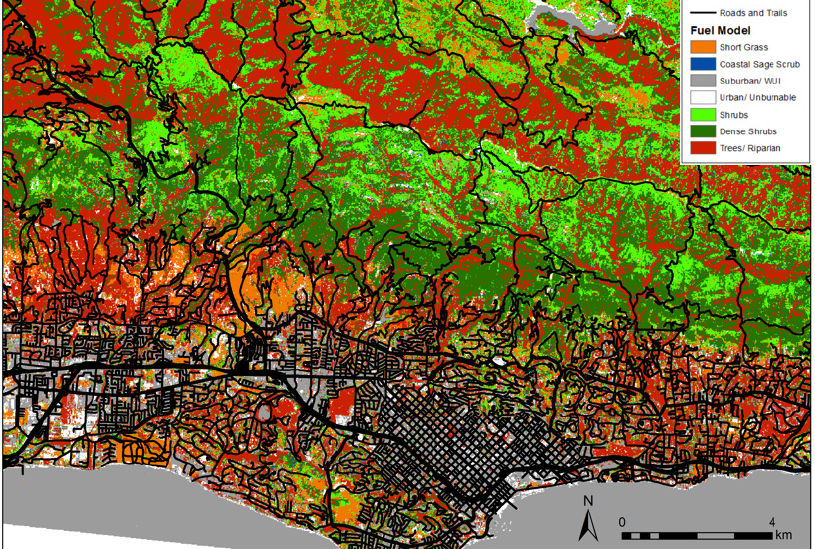
Figure A2. Fuel map for the wildfire simulations. Fuel model information can be found in [30].